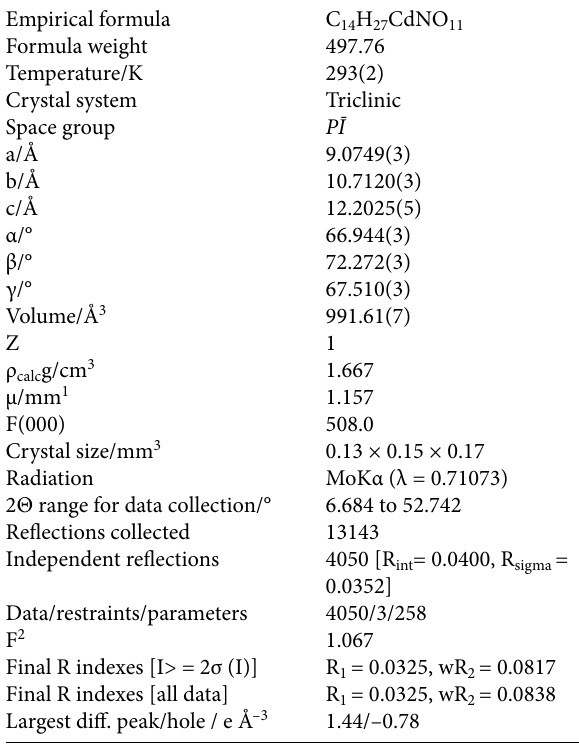
Table 1. Crystallographic data for [Cd(IsoPht)(TEA)H 2 O]·3H 2